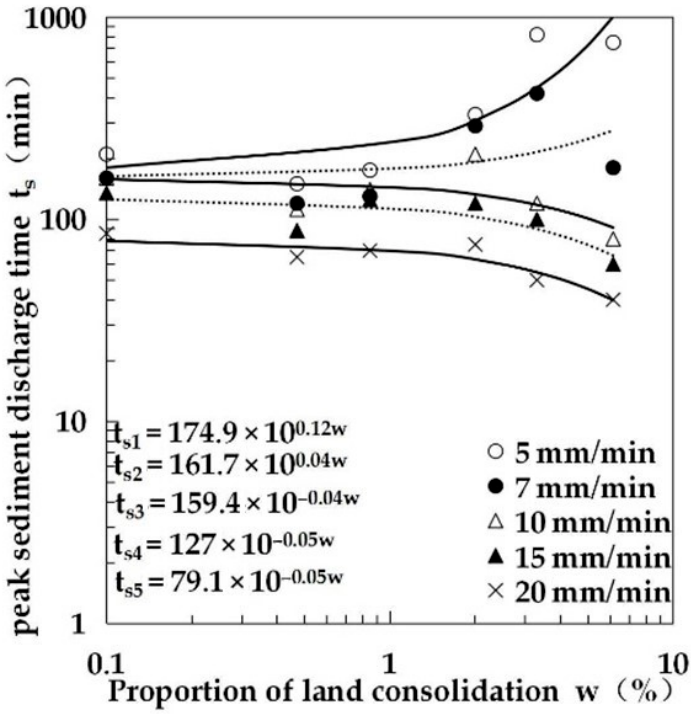
Figure 24. Changes in peak sediment discharge time with land consolidation proportion under different rainfall intensities.